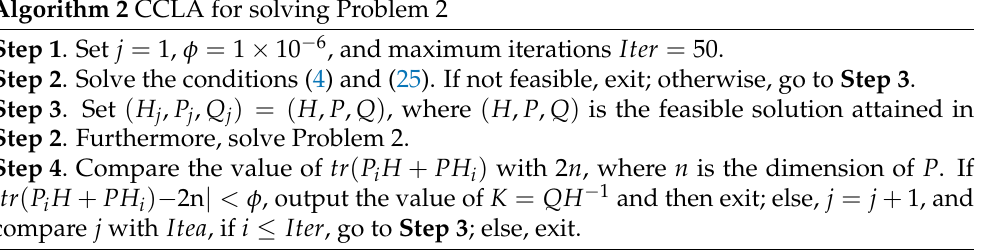
Algorithm 2 CCLA for solving Problem